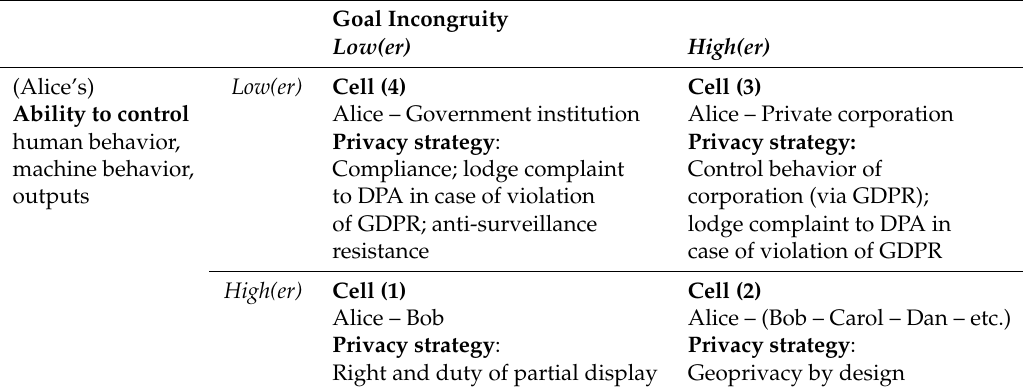
Table 1. A typology of (location) privacy